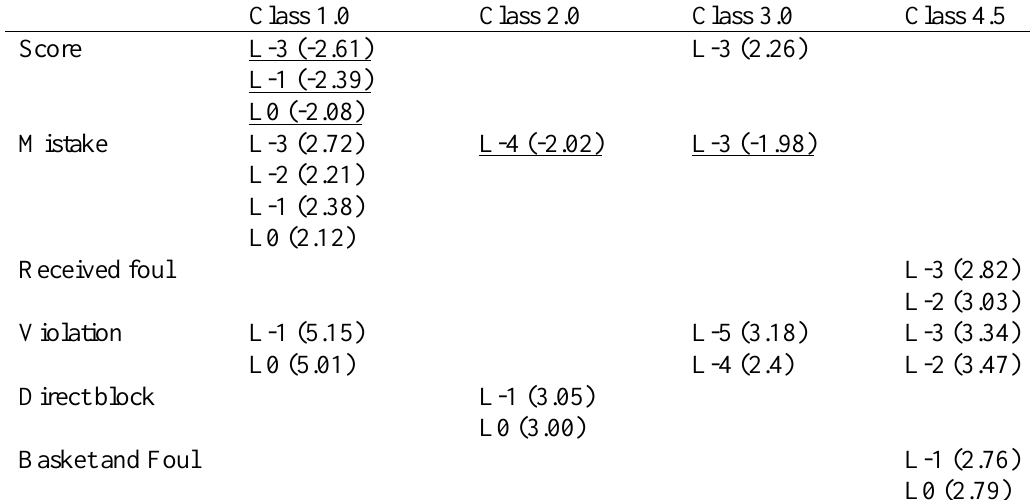
Table 4. Lag sequential analysis between the given categories of the Consequence of completion dimension and the target behaviours corresponding to the Classification level